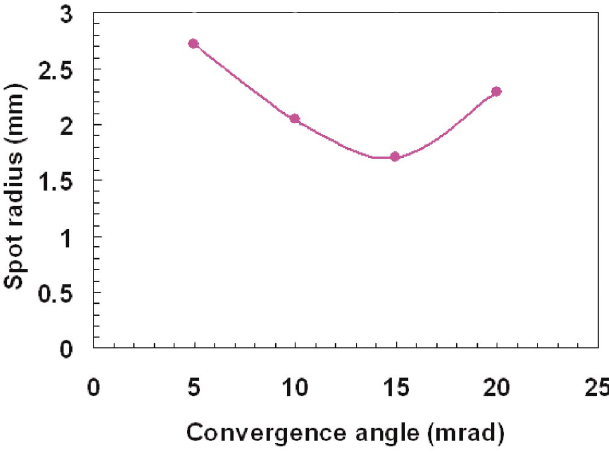
FIG. 13. (Color) Spot size as function of convergence angle.